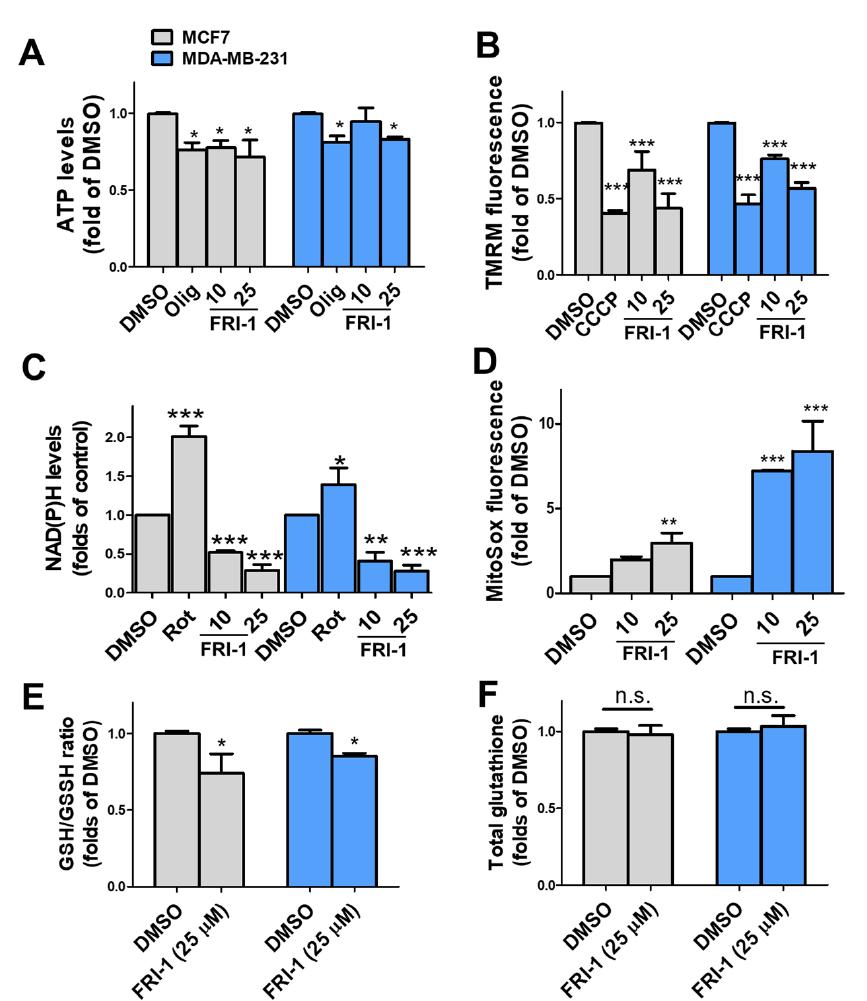
Figure 4. FRI-1 reduces mitochondrial bioenergetics, increasing mitochondrial ROS levels in breast cancer (BC) cells. ( A ) ATP levels; ( B ) Δψ m, ( C ) NAD(P)H, ( D ) mitochondrial reactive oxygen species (ROS) levels, ( E , F ) GSH/GSSG and total glutathione levels at 4 h of treatment. BC cells were treated for 4 h and bioenergetic parameters were determined as described in the Material and Methods section. Oligomycin (Olig, 1 µM), CCCP (200 nM), and rotenone (Rot, 1 µM). Data are shown as mean ± SD of three independent experiments. * p < 0.05, ** p < 0.01, *** p < 0.001, vs. control (DMSO). n.s.: Not